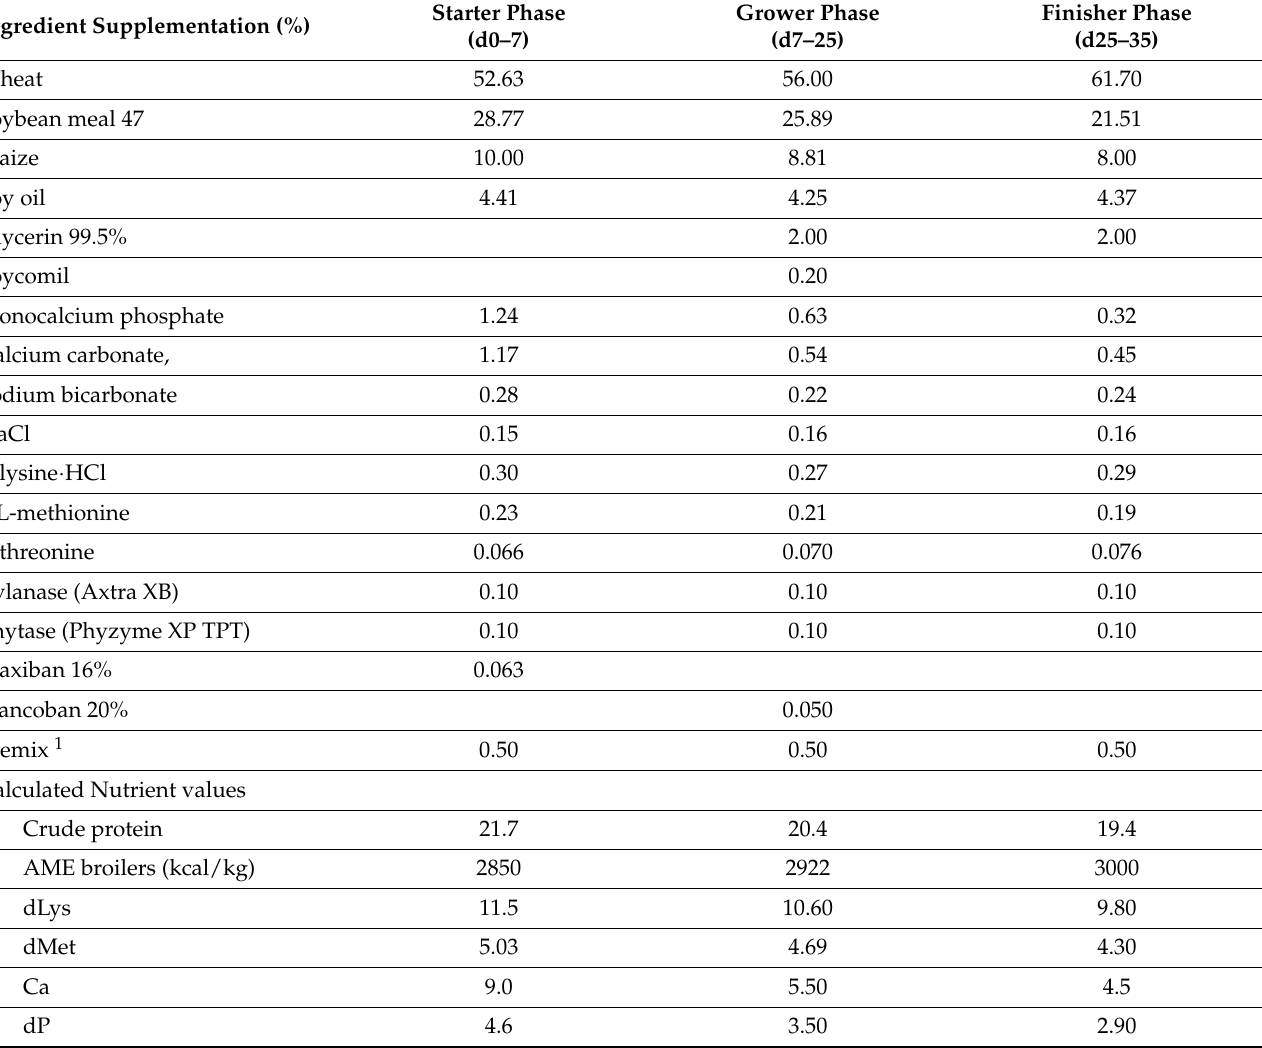
Table 1. Ingredient and nutrient composition of the experimental diets as fed to the birds sampled for metabolomics. Data are in % except where